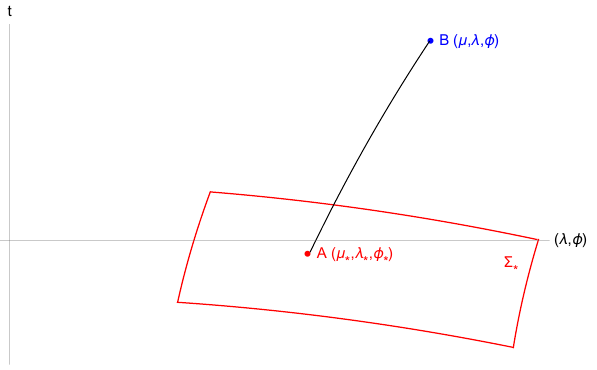
Figure 1 . The tree-level hypersurface is symbolically represented by (cid:6) (cid:3) . If we start from point A and travel a distance t 0 along the characteristic curve to reach point B , then we return to A by (cid:3) starting from B and by travelling the same distance in the opposite